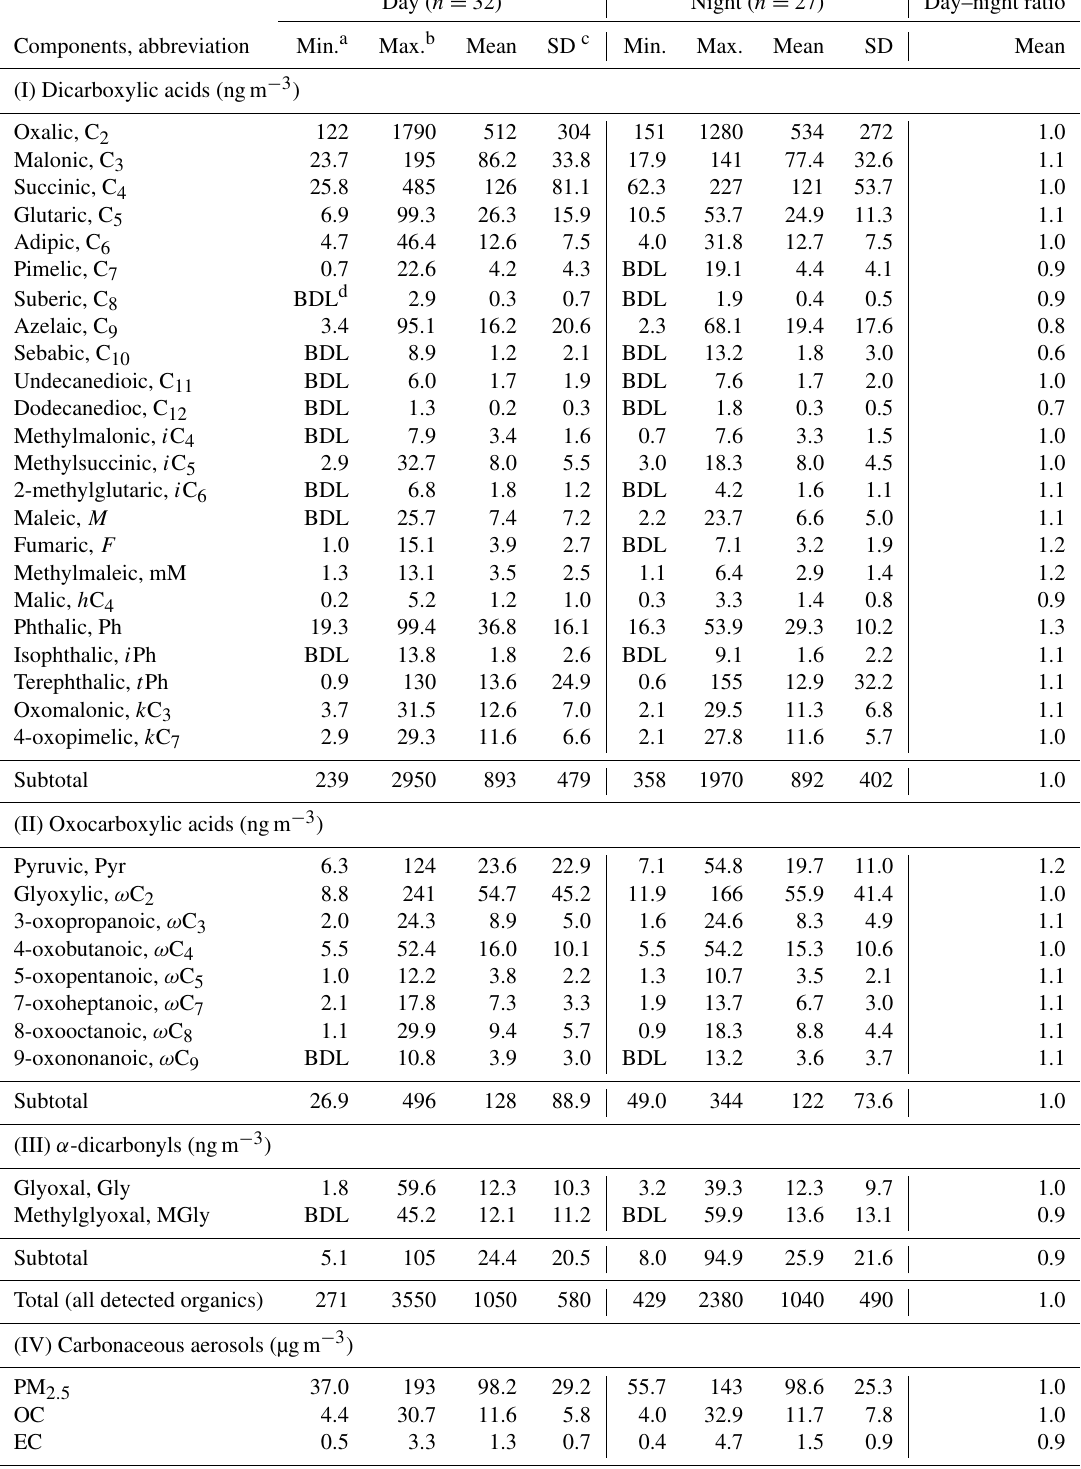
Table 1. Measured concentrations of DCRCs, PM 2 . 5 , OC and EC at the top of Mt. Tai from 4 June to 4 July